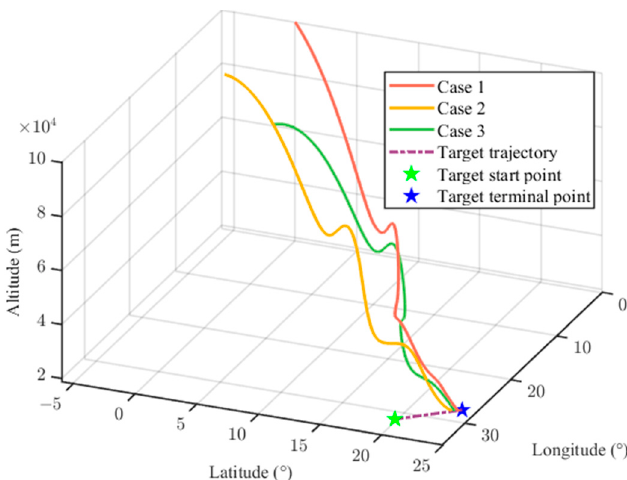
Figure 23. 3D reentry trajectory.